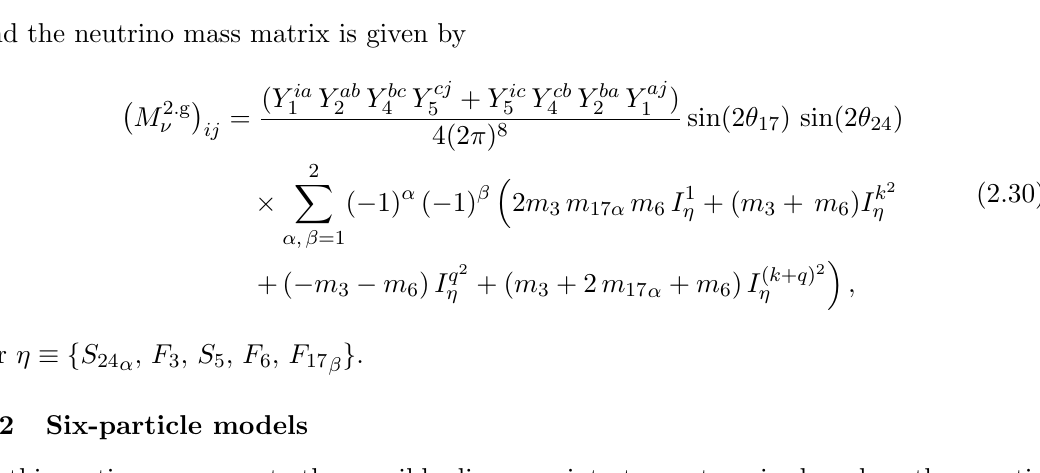
Figure 3. Two-loop diagrams for Class 3.a{3.c of Category